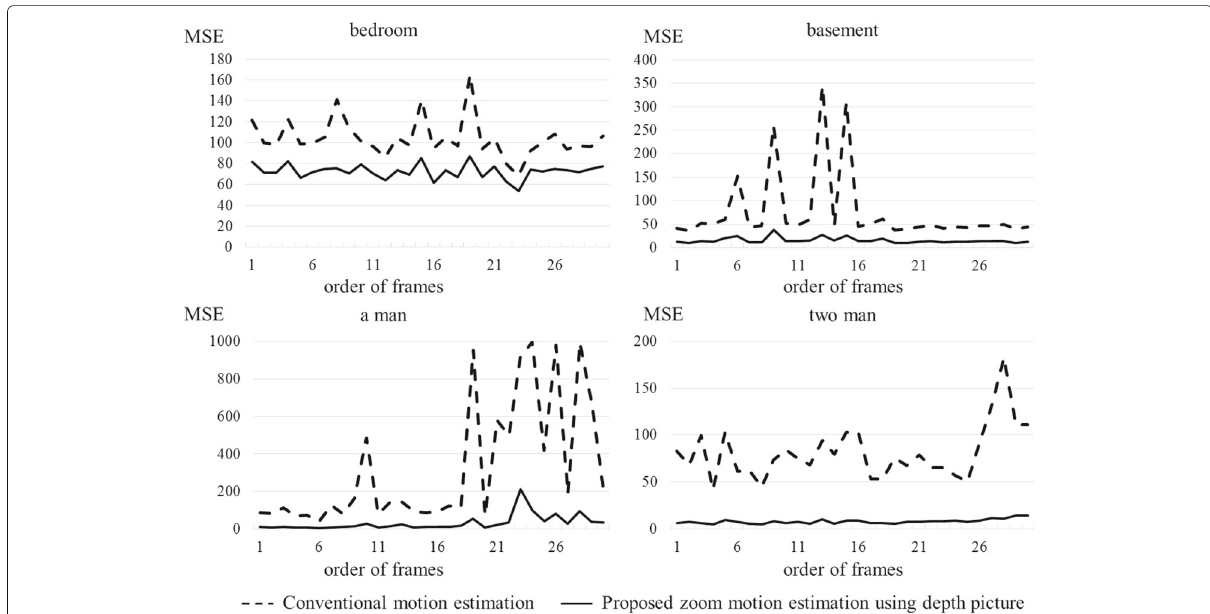
Fig. 13 Comparison of MSEs between conventional and proposed methods for depth videos (8 × 8 block size)